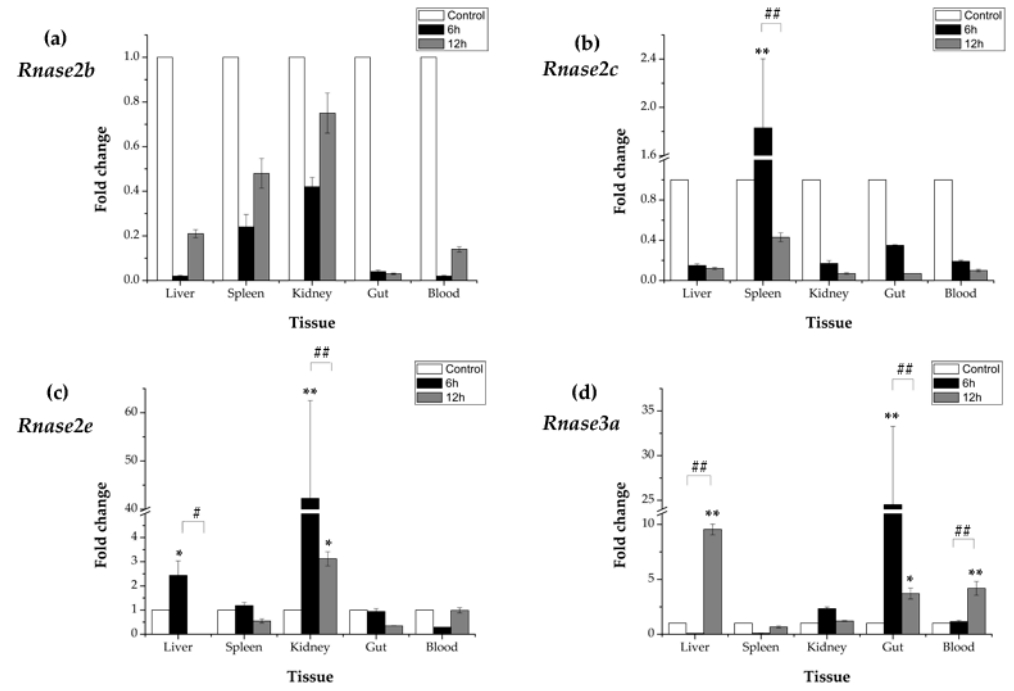
Figure 5. Messenger RNA (mRNA) after Aeromonas hydrophila infection in five different tissues ( a ) Expression of Rnase2b , ( b ) Rnase2c , ( c ) Rnase2e and ( d ) Rnase3a . β -actin was used as the internal reference. Results are presented as the mean ± standard error among three replicates, where significant differences ( p < 0.05) between control and test groups are marked with *, and highly significant differences ( p < 0.01) with **. # p < 0.05 and ## p < 0.01 show significant differences between the designated groups. 6h: 6 h after A. hydrophila infection; 12h: 12 h after A. hydrophila infection.